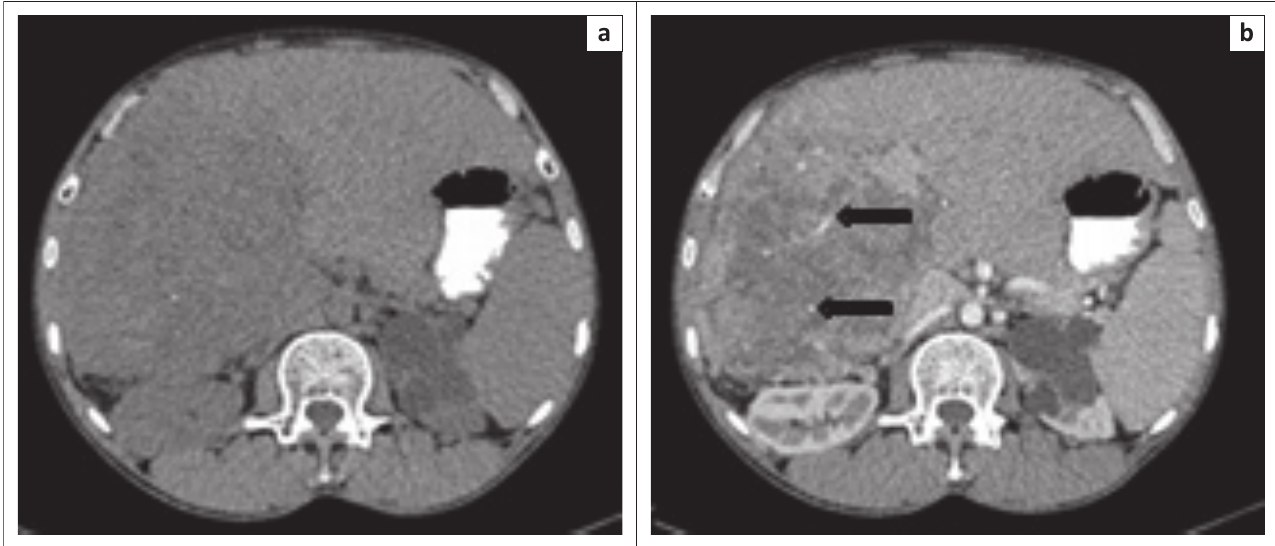
FIGURE 1: A 73-year-old man who presented with abdominal pain. Axial computed tomography scan images: (a) precontrast; (b) arterial phase shows abnormal internal vessels (black